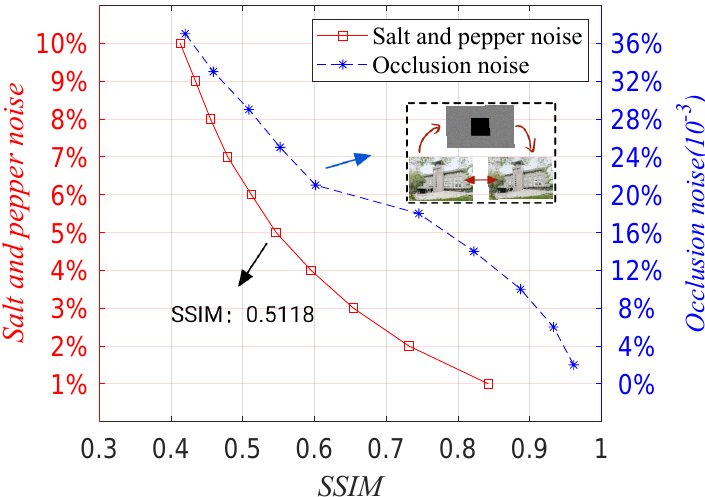
Figure 14. SSIM value under salt and pepper noise and occlusion